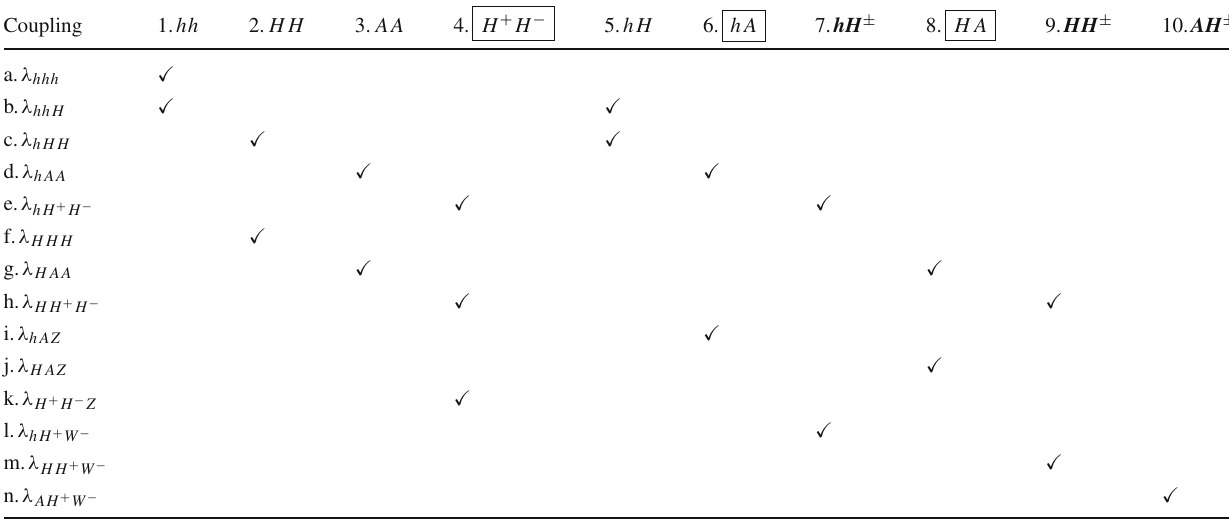
Table 3 The ten 2BFS combinations available in the 2HDM. Charged 2BFSs, which can only be q ¯ q ( (cid:2) ) -produced, are typeset in bold in the top row, while a box around a neutral 2BFS implies that the cross section for its production from q ¯ q ( (cid:2) ) -initiated processes can exceed that from